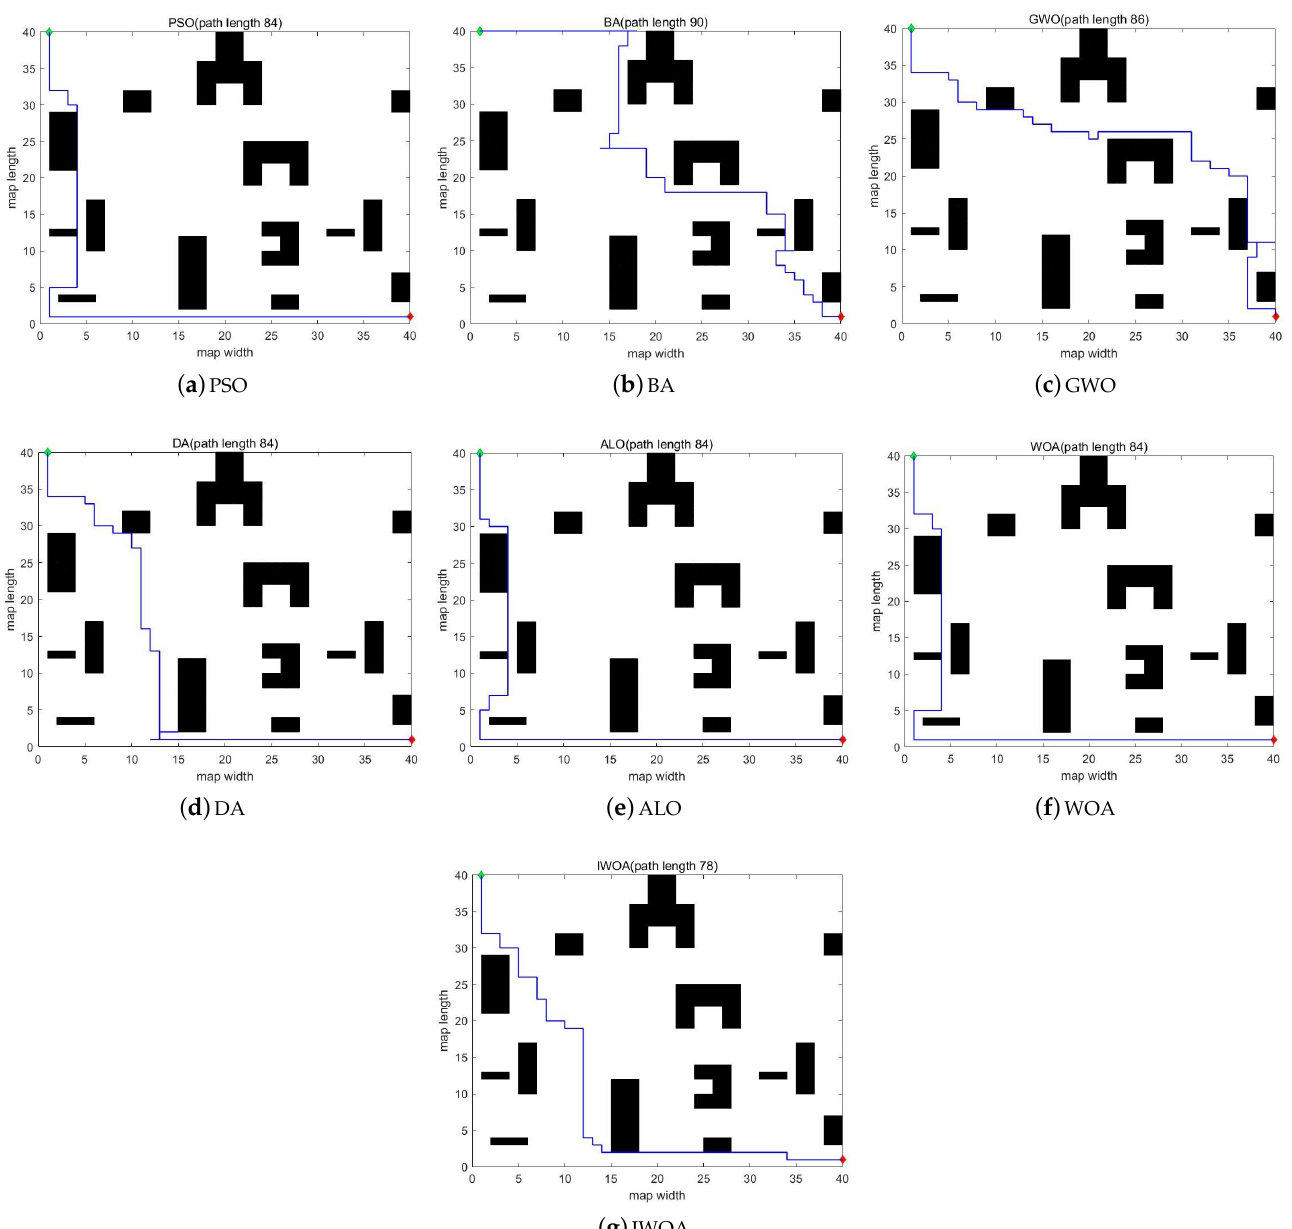
Figure 14. Actual path traces of seven different algorithms on 40 × 40 size